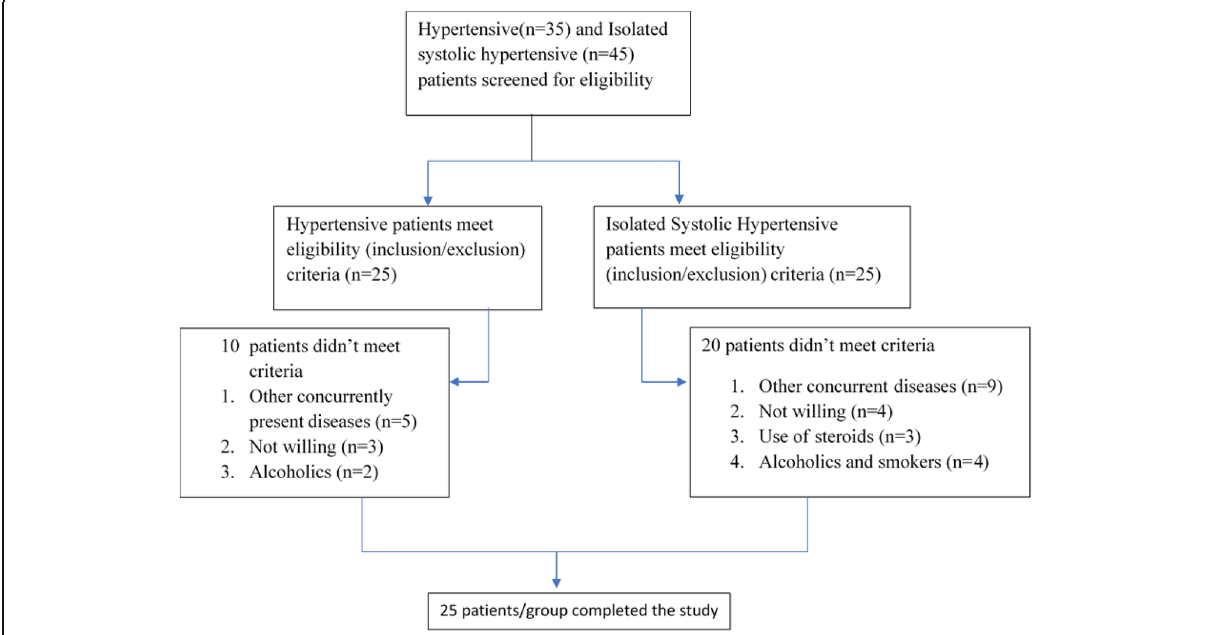
Fig. 1 Selection criteria of study